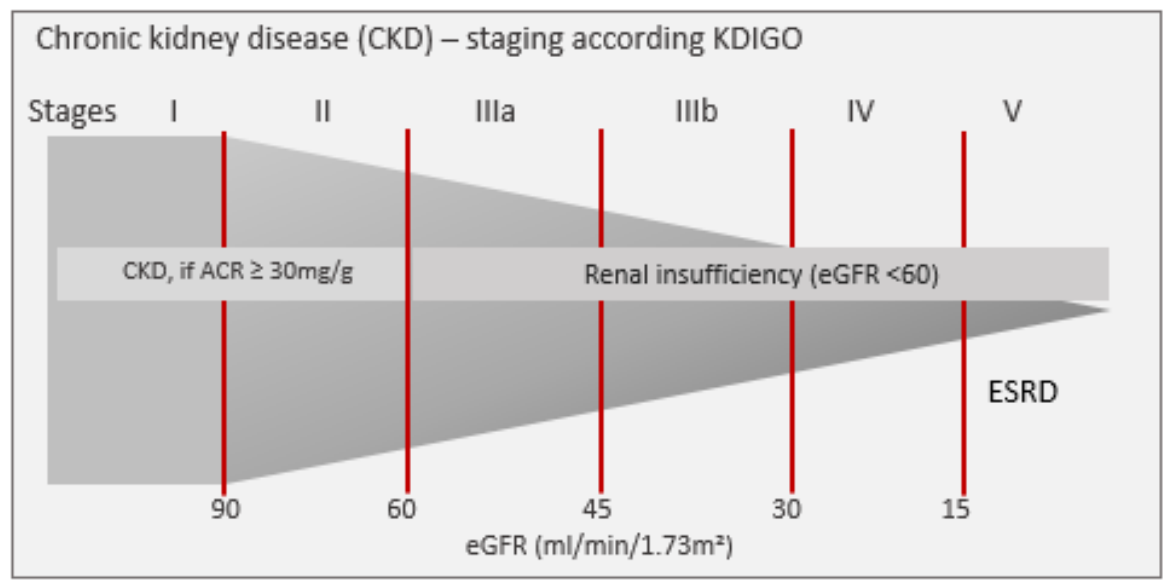
Figure 1. CKD staging according to decreasing renal function defined by albuminuria and estimated glomerular filtration rate (eGFR). ACR = albumin/creatinine ratio, CVD = cardiovascular disease, ESRD = end stage renal disease, KDIGO = Kidney Disease Improving Global Outcomes (=Guideline).